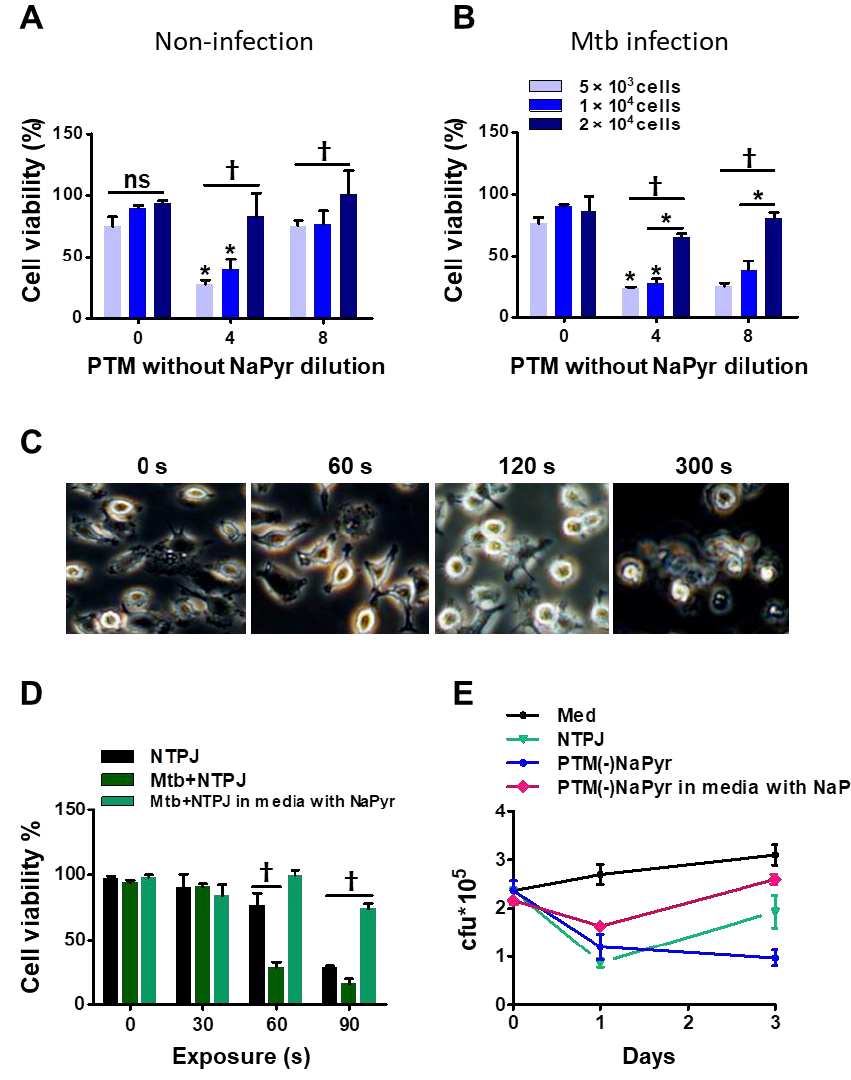
Figure 5. Identification of optimal PTM dilution to induce cell death ex vivo but remain non-toxic to uninfected BMDMs. Direct plasma NTPJ and PTM reduced intracellular Mtb growth. ( B ) Viability of ( A ) uninfected and ( B ) Mtb -infected cells (5 × 10 3 , 1 × 10 4 , and 2 × 10 4 /well of 96-well plates) determined 24 h after incubation with diluted PTM without NaPyr using CCK-8 assays. ( C ) Representative morphological features of Mtb -infected BMDMs after direct plasma exposure for 0, 60, 120, and 300 s. ( D ) Viability of uninfected and Mtb -infected BMDMs (1 × 10 4 /well of 96-well plates) after exposure to NTPJ for 30, 60, and 90 s in medium containing NaPyr under same conditions. * p < 0.01 and † p < 0.001; two- or one-way ANOVA. Error bars show the standard deviation of the means of three independent experiments. ( E ) Growth of intracellular bacteria assessed using CFU assays, immediately or one or three days after exposure to NTPJ for 60 s and 8-fold-diluted PTM in a medium with or without NaPyr. Colony-forming units were determined in cultures on 7H10 agar plates. p < 0.01, NTPJ and p < 0.001, PTM without NaPyr vs. untreated control on day 3; n = 3. p < 0.001, NTPJ and PTM without NaPyr vs. untreated control on day 1.